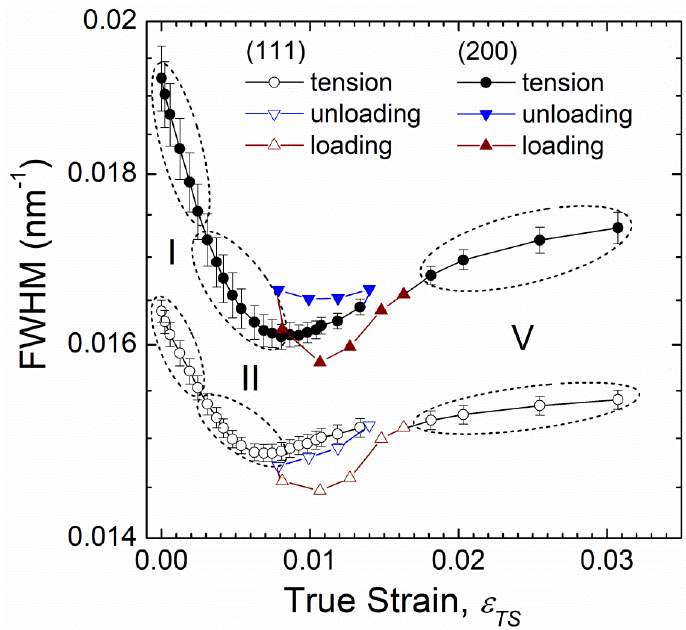
Figure 3. FWHM for reflections (111) and (200) versus macroscopic true strain ( ε TS ) for bulk nc-Ag in tension and during unloading-loading.